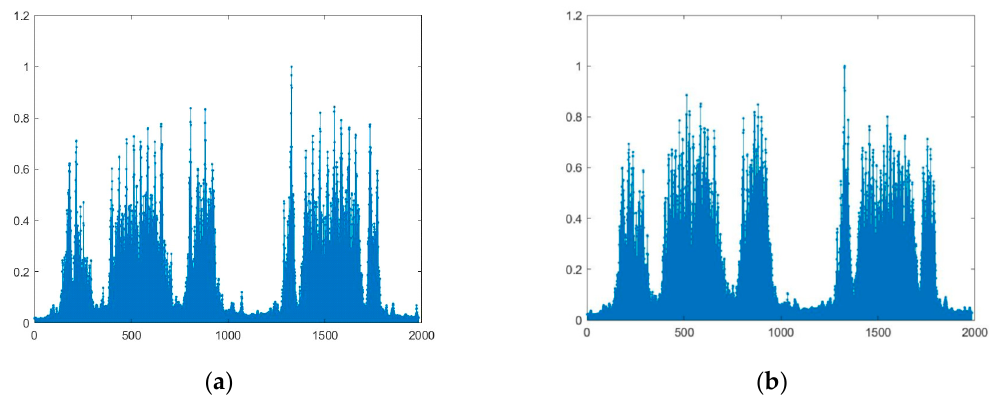
Figure 9. ( a ) Average intensity variations of multiple rows of pixels above and below the row of interest of the optical reconstructed image of the SPOH, generated based on down-sampling factor τ = 16, ( b ) average intensity variations of multiple rows of pixels of the reconstructed images of the SPOH after applying our proposed TDCF method.